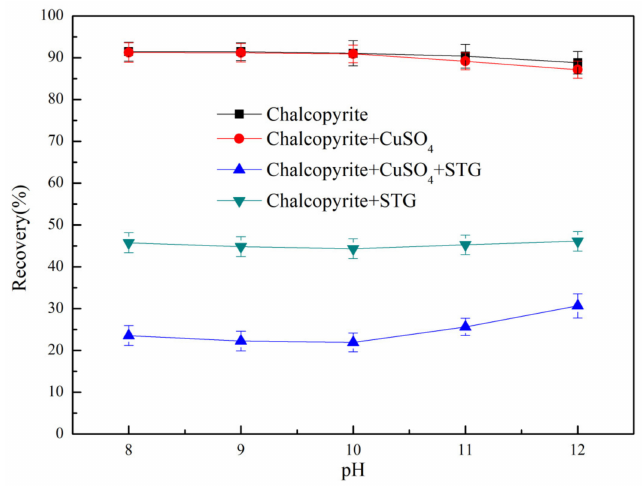
Figure 4. The flotation recovery of chalcopyrite under di ff erent pH values; c(Cu 2 + ) = 1 × 10 − 3 mol / L, c(STG) = 1.5 × 10 − 3 mol / L, c(BX) = 1 × 10 − 3 mol /